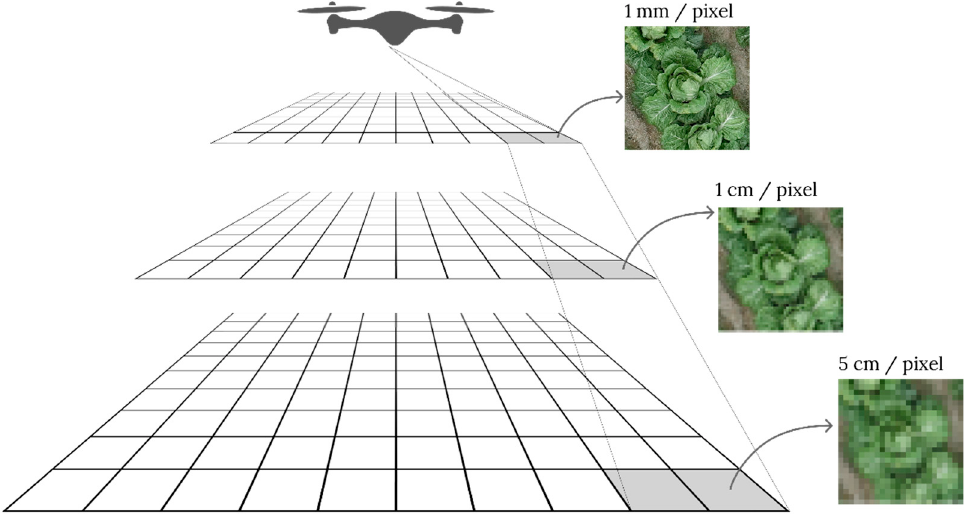
Figure 3. Effects of different flight altitudes on the GSD.